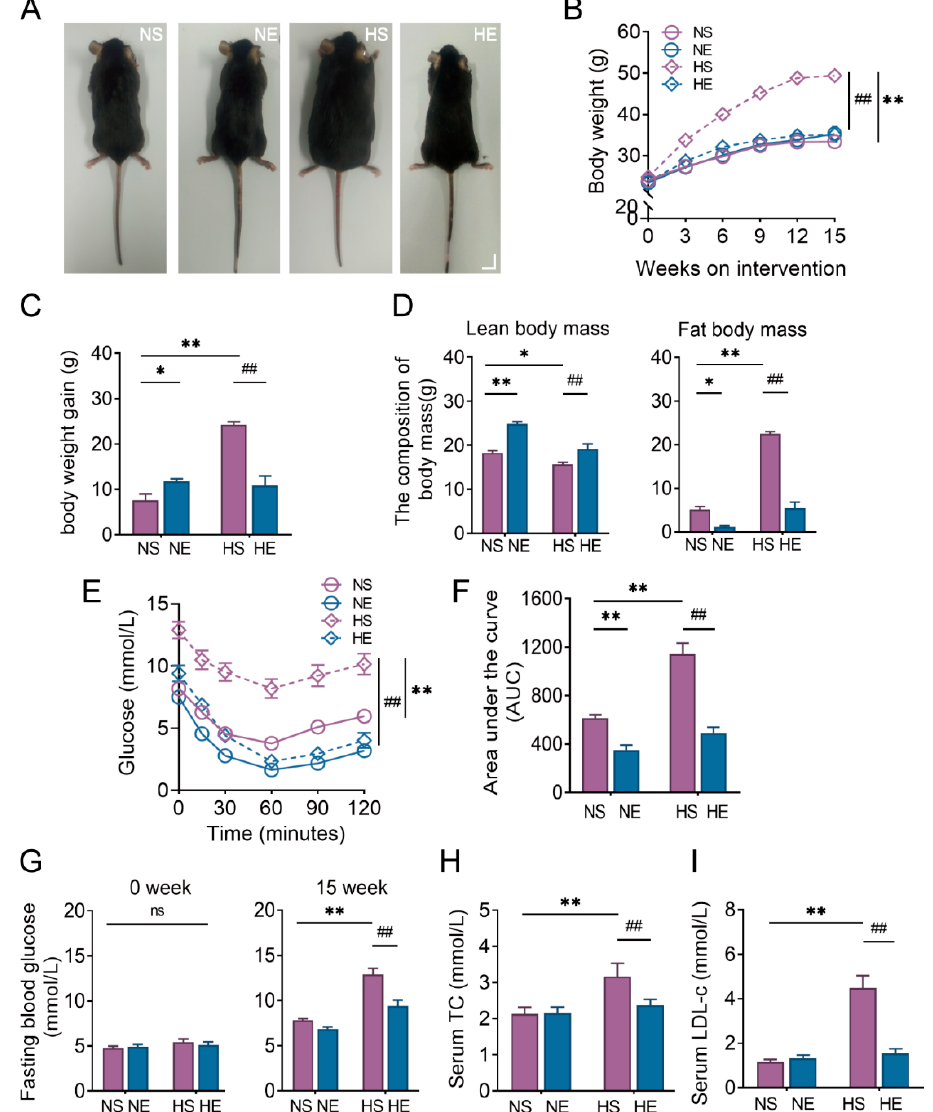
Figure 2. Exercise training alleviates the NALFD-related risk factors in HFD mice. The beneficial effect of exercise in preventing NAFLD was shown by ( A ) the appearance of mice after 15 weeks of intervention (scale bar: 10 mm), ( B , C ) body weight and gain of mice, ( D ) body composition, ( E , F ) insulin sensitivity tested by ITT, ( G ) fasting blood glucose before and after the intervention, and ( H , I ) serum TC and LDL-c. Unless otherwise specified, six mice per group were used in each experiment. The data are expressed as mean ±SEM. * p < 0.05, ** p < 0.01 versus NS mice; # p < 0.05, ## p < 0.01 versus HS mice.